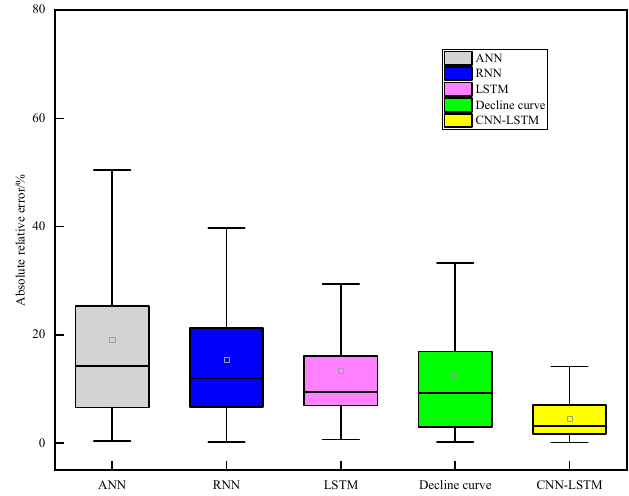
Figure 10. Absolute relative error boxplot of five models.